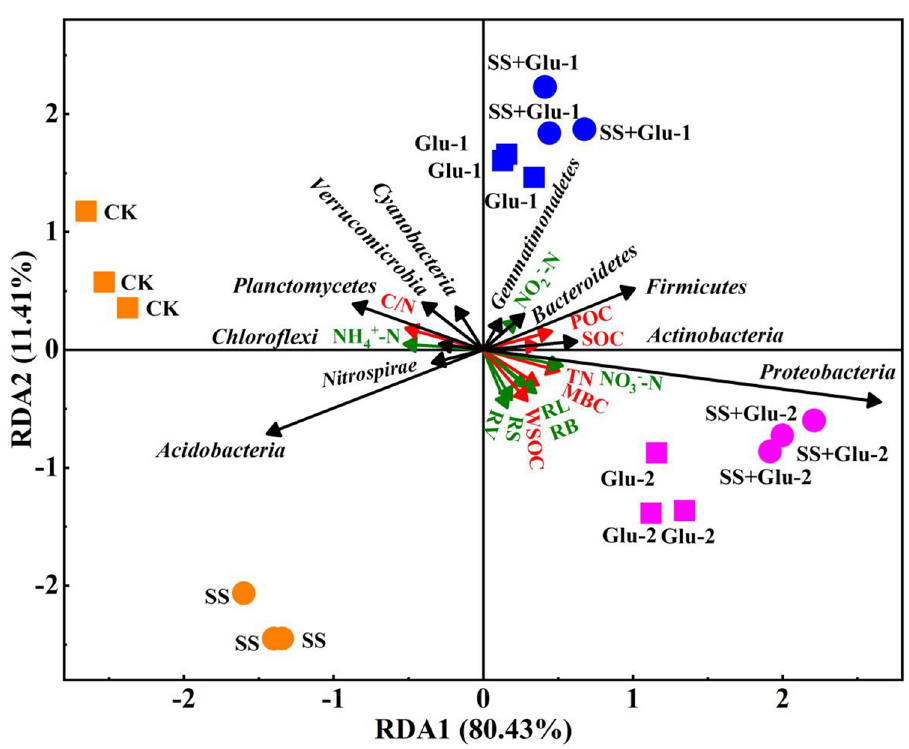
Fig 8. Redundancy analysis of the relationship among soil bacterial communities (black arrow) at the phylum level, soil nitrogen and organic carbon fractions (red arrow), and root morphology indices (green arrow). MBC, microbial biomass carbon; SOC, soil organic carbon; TN, total nitrogen; C/N, ratio of soil organic carbon to total nitrogen; POC, particulate organic carbon; WSOC, water-soluble organic carbon; NH 4+ -N, ammonium nitrogen of root; NO 3— N, nitrate nitrogen of root; NO 2— N, nitrite nitrogen of root; RV, root volume; RS, root surface; RL, root length; RB, root biomass. Square and circle denote the non-sterilized and sterilized soils, respectively. CK, non- sterilized soil without glucose addition; Glu-1, non-sterilized soil with low level of glucose addition; Glu-2, non- sterilized soil with high level of glucose addition; SS, sterilized soil without glucose addition; SS+Glu-1, sterilized soil with low level of glucose; SS+Glu-2, sterilized soil sterilization with high level of glucose addition.